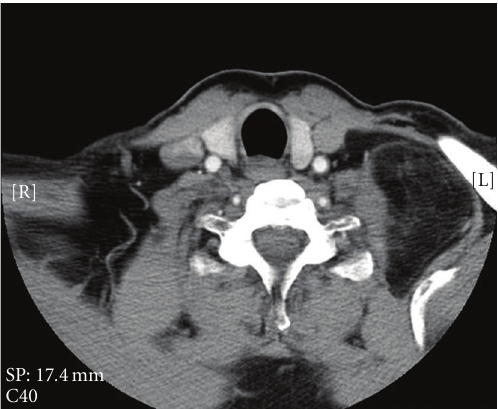
Figure 2: Axial CT scan of the neck showing extension of left supraclavicular mass posteriorly.